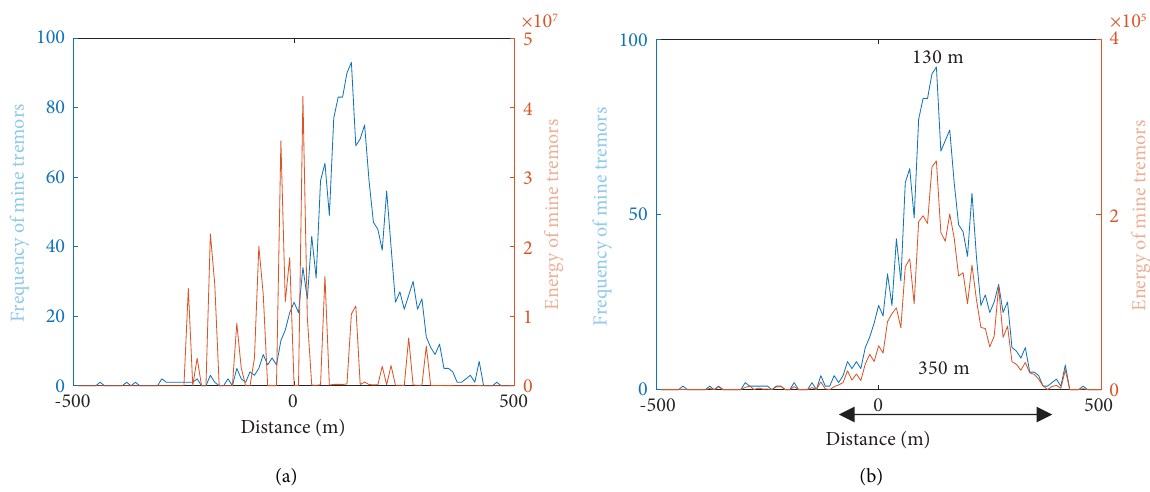
Figure 12: Te distribution law of mine tremors near the extraction location of panel 63upper06. (a) Statistical results including all mine tremors. (b) Statistical results after eliminating mine tremors over 10 5